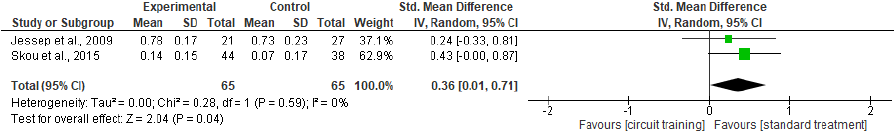
Figure 8. Forest plot analysis of the effect of CT on health-related quality of life [42,43]. Knee Symptom There was no difference in knee symptom outcomes (SMD 0.26, 95% CI − 0.05–0.58; I² statistic = 11%; p = 0.10; two trials, 175 participants; high-quality evidence) [41,43] (Figure 9, Table 2) between the CT group and standard treatment group. Figure 9. Forest plot analysis of the effect of CT on knee symptom [41,43].